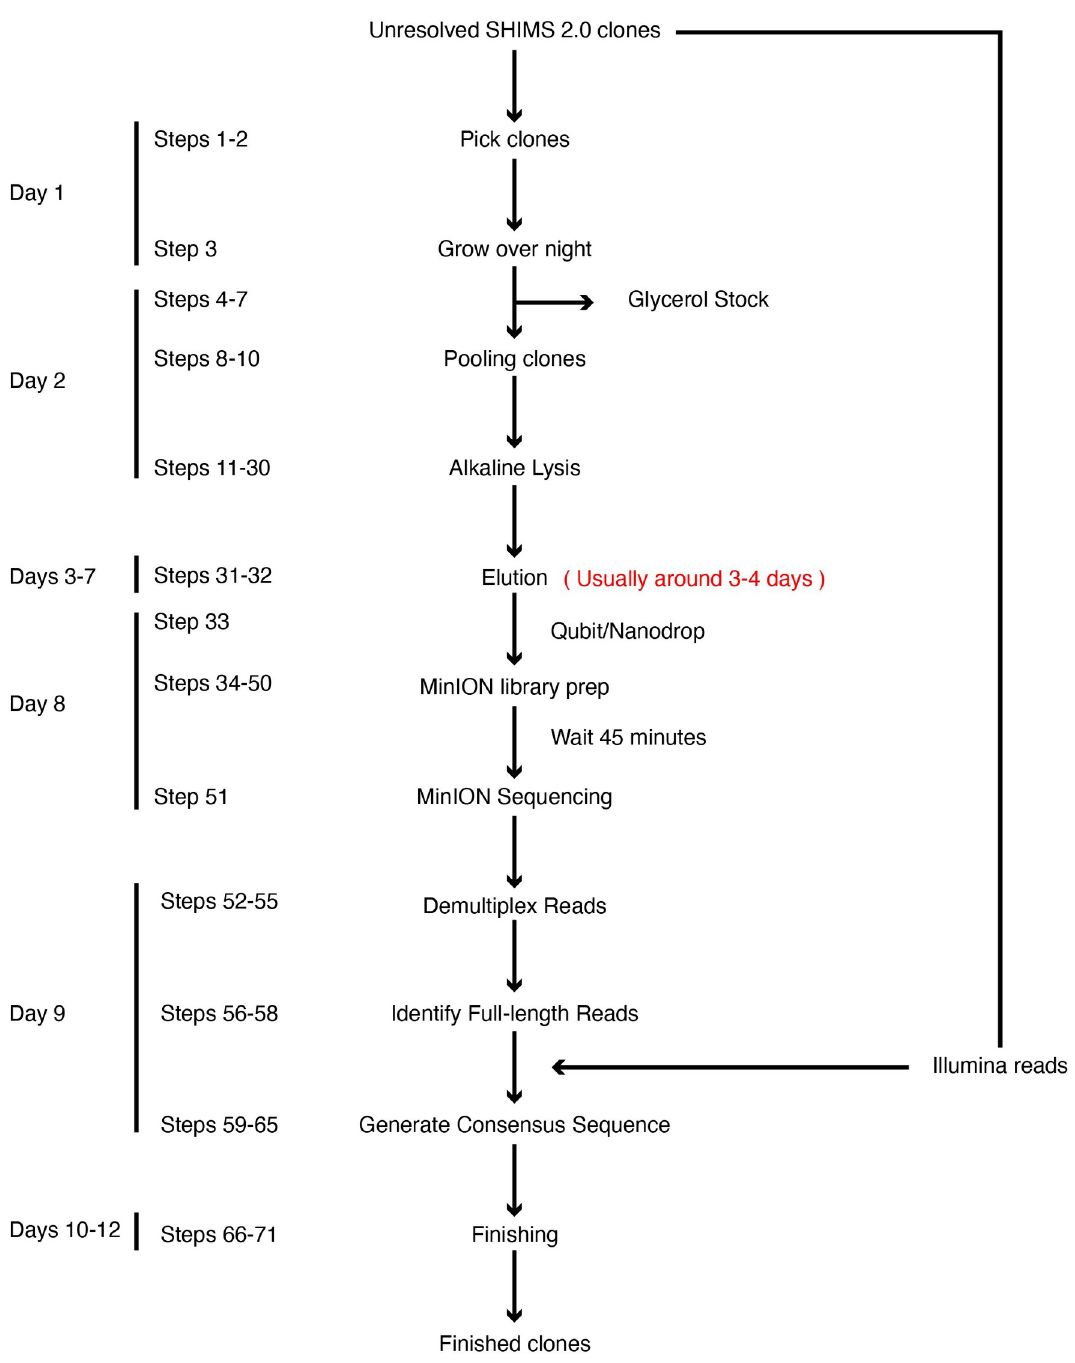
Fig 1. Overview of the SHIMS3.0 protocol. A timeline of a single iteration of the SHIMS 3.0 protocol, showing the major protocol steps, with key quality controls on the right. During a two-week iteration, 24 clones are processed in parallel to rapidly generate finished sequence from structurally complex clones. A single technician can proceed from a list of clones to full-length nanopore libraries in 8 d. After a brief MinION run overnight, a bioinformatics specialist can demultiplex fastq sequences, identify full-length reads, then polish and edit the consensus of these reads to generate finished clone sequence.